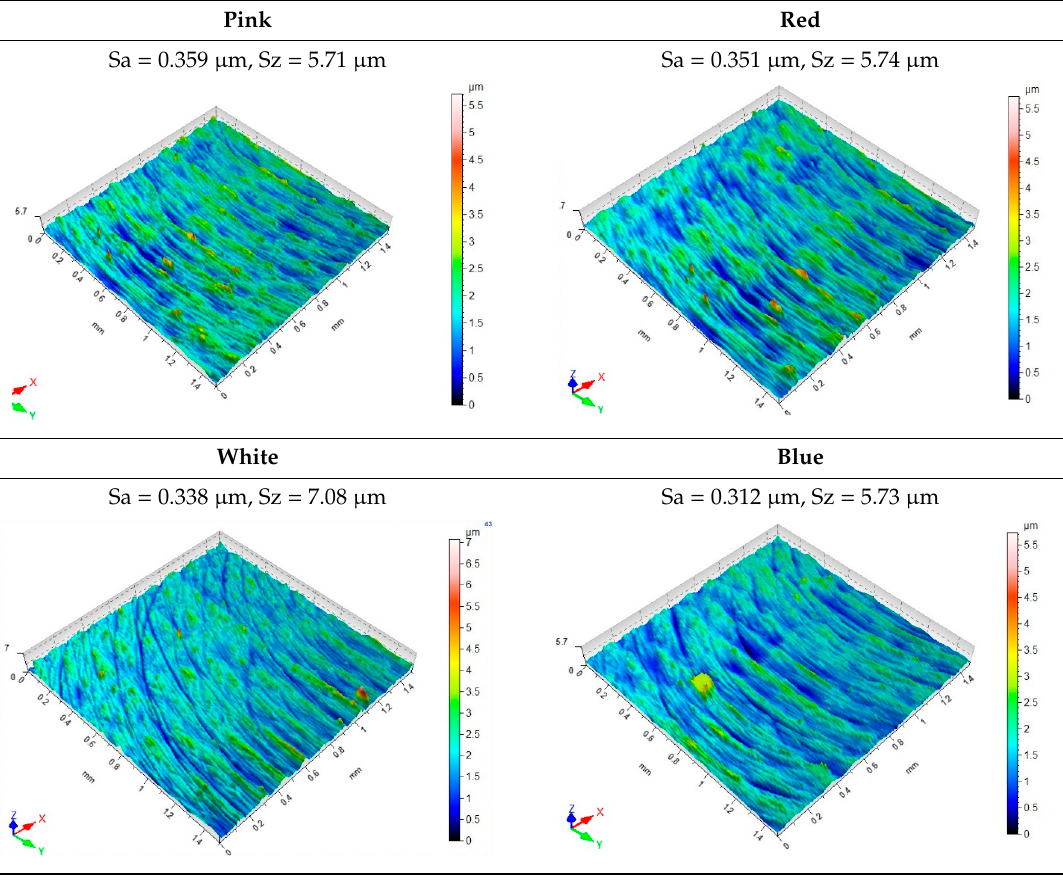
Table 4. Surface topography after brushing with the “high” spring in the offset adjustment sleeve. Pink